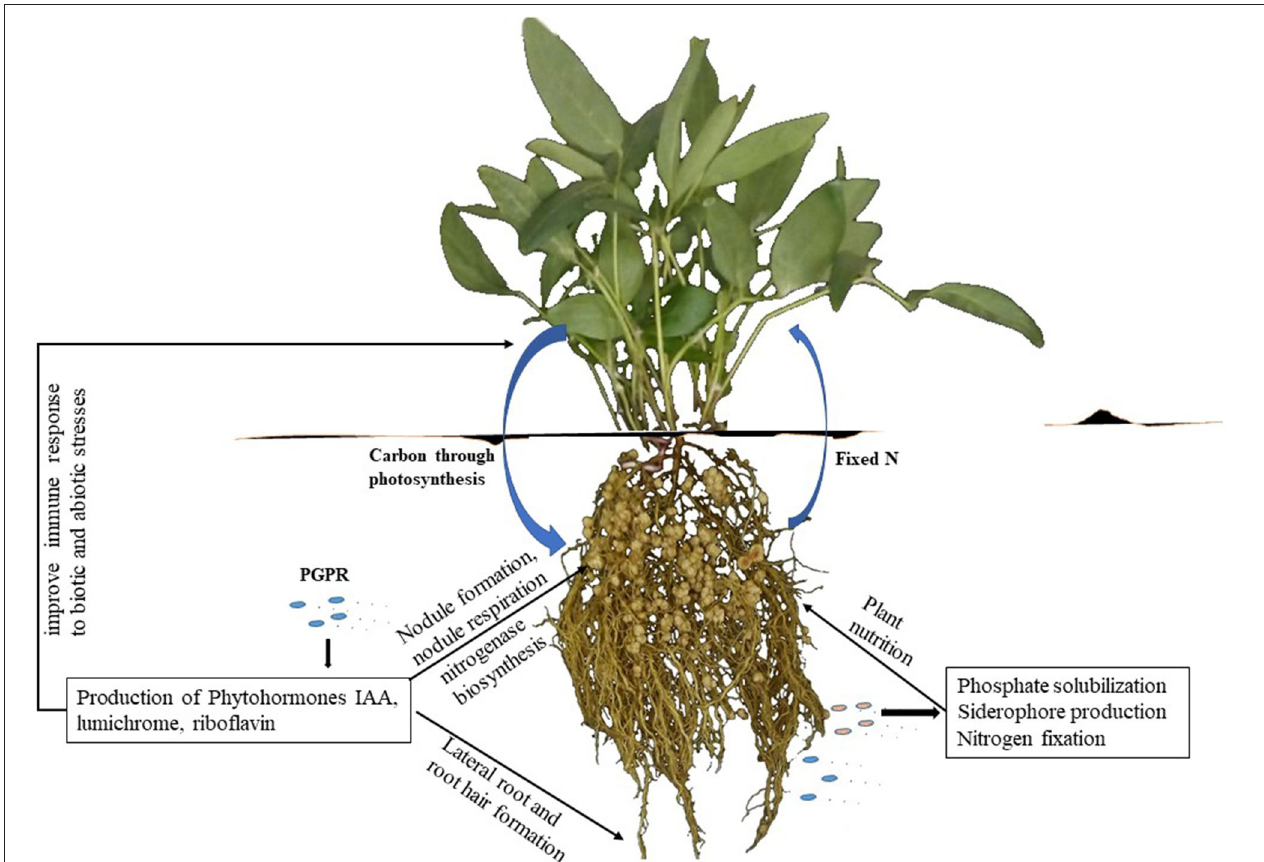
FIGURE 1 | Plant growth promoting activities in the rhizosphere. Microsymbionts are activated by rhizodeposition of carbon and other signal molecules by the plant. After establishment of the PGPR in the rhizosphere, they promote plant growth by releasing growth substances and alleviating the effects of biotic